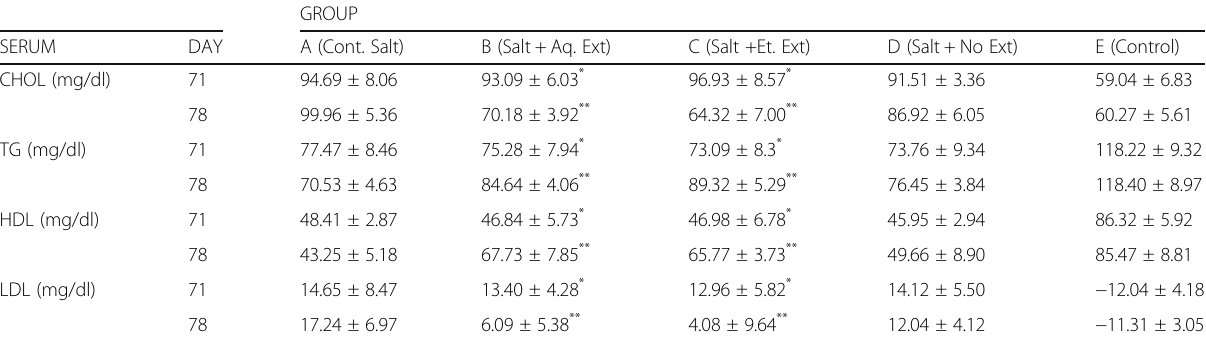
Table 1 Serum Cholesterol, Triglycerides, HDL-Cholesterol, LDL-Cholesterol (mg/dl) of salt-loaded rabbits; treated with aqueous (B) and ethanol (C) extracts of Acalypha wilkesiana leaves, continuous salt loading (A), salt loaded and non-treated (D), non-loaded and non-treated (E) GROUP